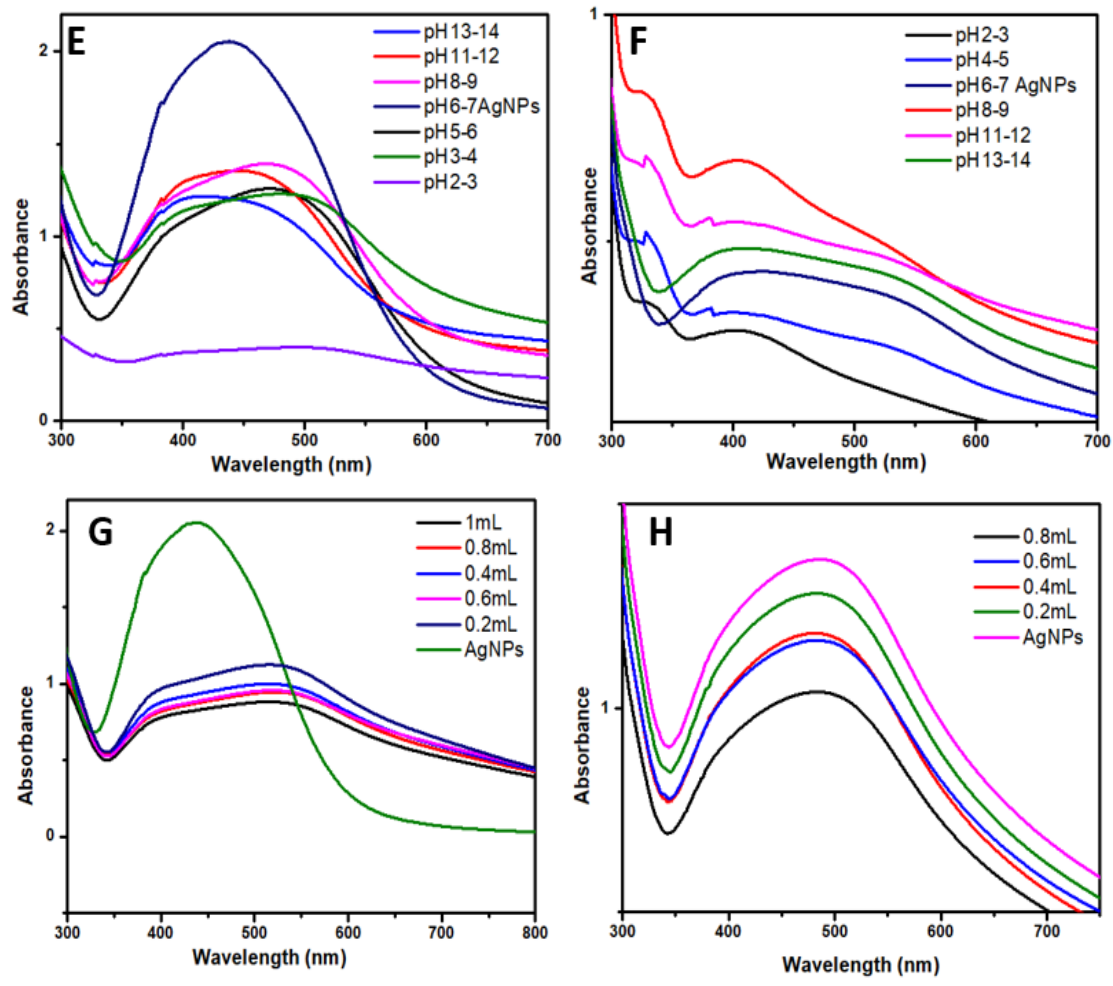
Figure 4. ( A , B ) UV-visible spectra of AgNPs/ A. vittata having different AgNO 3 /Plant ratios, ( C , D ) effect of pH on the stability of AgNPs, ( E , F ) effect of temperature on the stability of AgNPs, and ( G , H ) effect of salt (NaCl) on the stability of AgNPs.